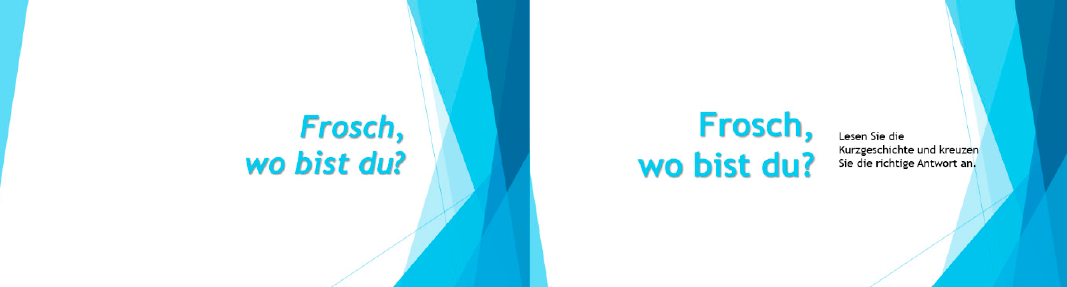
Figure A27. Posttest: Binary-choice recognition task.